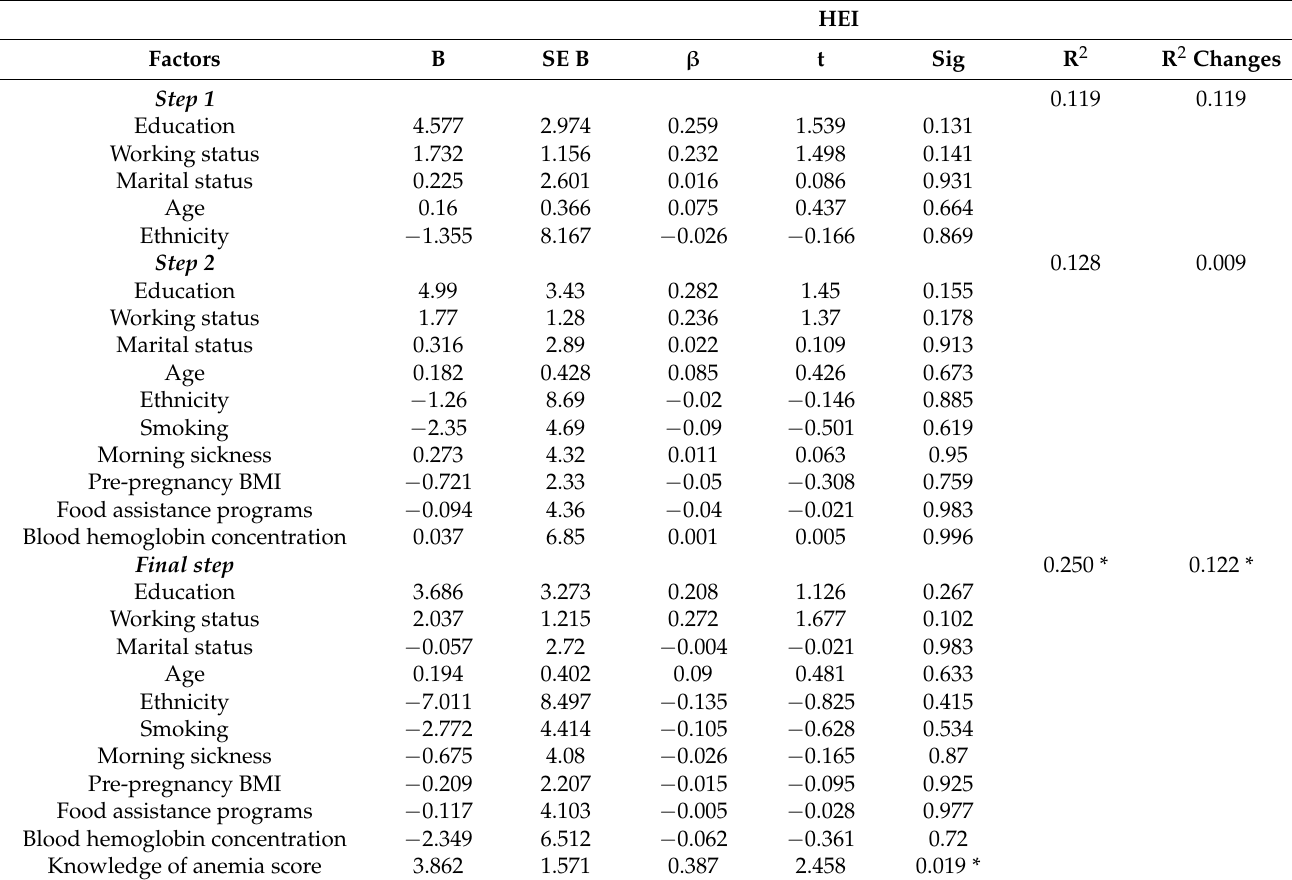
Table 8. Regression analysis predicting survey 1 HEI scores from maternal characteristics and nutritional